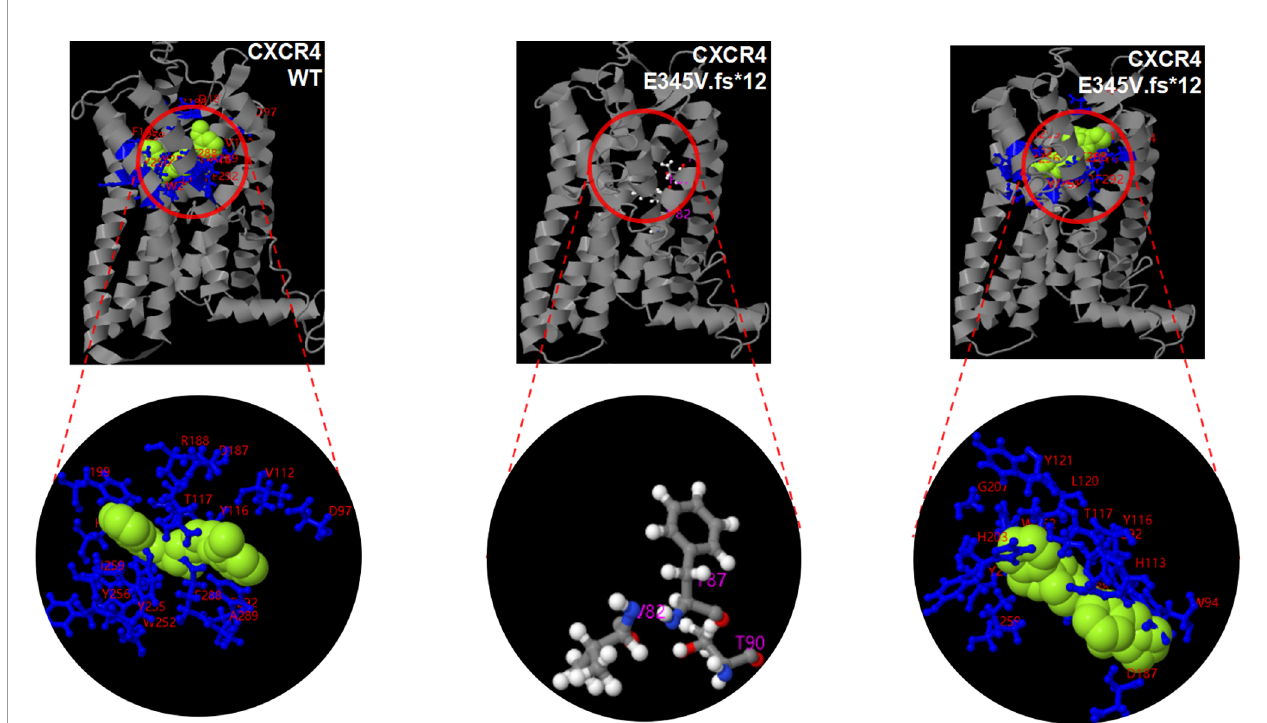
FIGURE 4 | Potentially pathogenic variants may affect the function of CXCR4 protein. 3D modeling of the p. E345V.fs*12 variant reveals disruption of the spatial structure of the N- and C- terminal region and alterations to the position and numbers of ligand binding site residues and active sites, when compared with WT CXCR4. There is no active site in three-dimensional modeling of WT CXCR4 predicted by COFACTOR and COACH. Light green balls represent ligand. Ligand binding site residues are shown by blueline and marked with red number. The active sites are represented by white and gray hockey stick